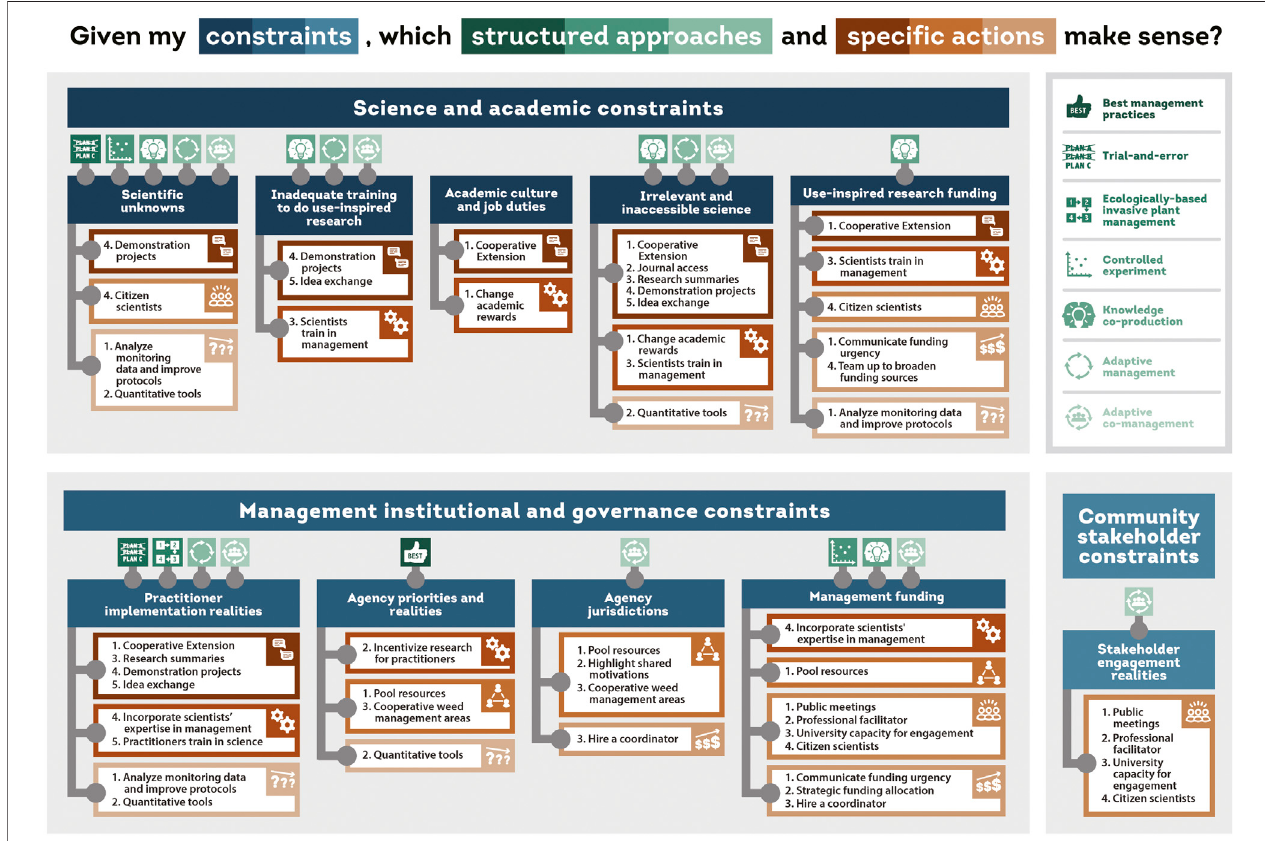
FIGURE 4 | Addressing constraints: Despite the numerous and diverse constraints to wetland invader management, a portfolio of structured approaches and speci fi c actions can be employed to overcome them. However, some constraints (e.g., “ Academic culture and job duties ” ) are not addressed by any or most of the structured approaches we describe. Other constraints can be accomplished by many different structured approaches (e.g., “ Practitioner implementation realities ” ) and speci fi c actions (e.g., “ Funding for management ” ). How each structured approach or speci fi c action is carried out in practice is poorly documented. Furthermore, the extent to which constraints are addressed will vary by the degree to which a structured approach or speci fi c action is implemented.